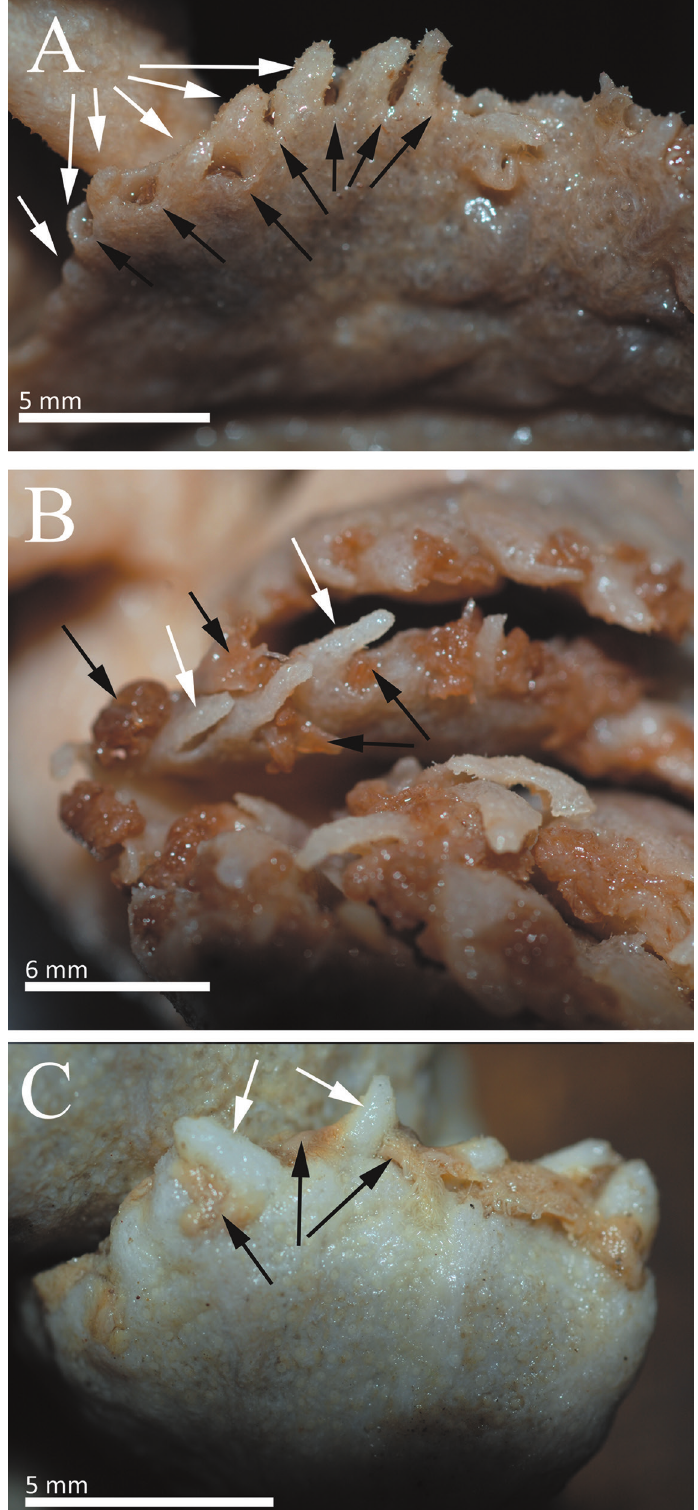
Fig. 7. Gyrophyllum hirondellei Studer, 1891. Details of the ventral edge of a polyp leaf, showing the apertures of an autozooid (black arrows) and a single BPP (white arrows) in differing degrees of development per autozooid. A–B . Colony BECA (OPEN-661). C . Colony MNHM